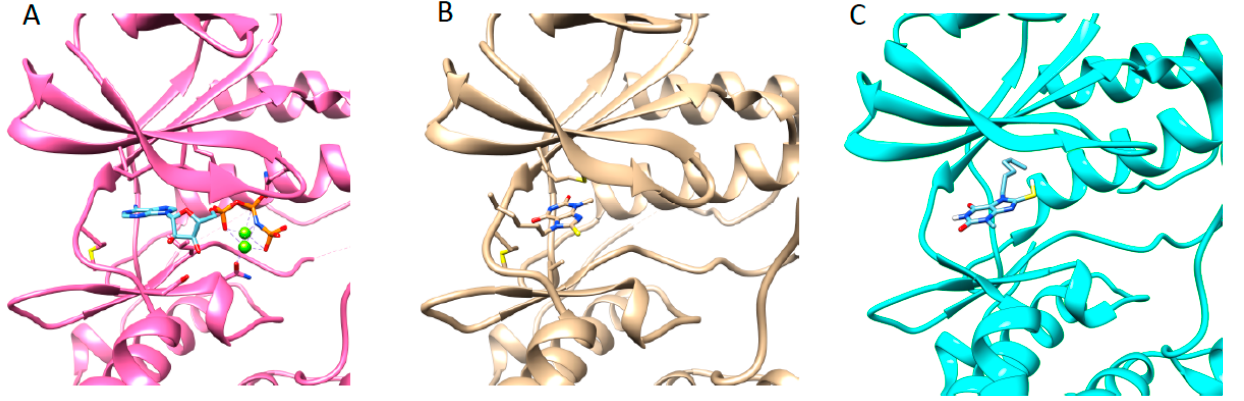
Figure 4. Structure of JNK3 in complex with AMP-PNP (( A ), PDB ID, 1JNK) and fragment 3A8 ( B ), and docking simulated structure of JNK3 with 3A8 ( C ). Small molecules were presented by stick. In AMP-PNP bound structure, two magnesium ions were involved in the complex.